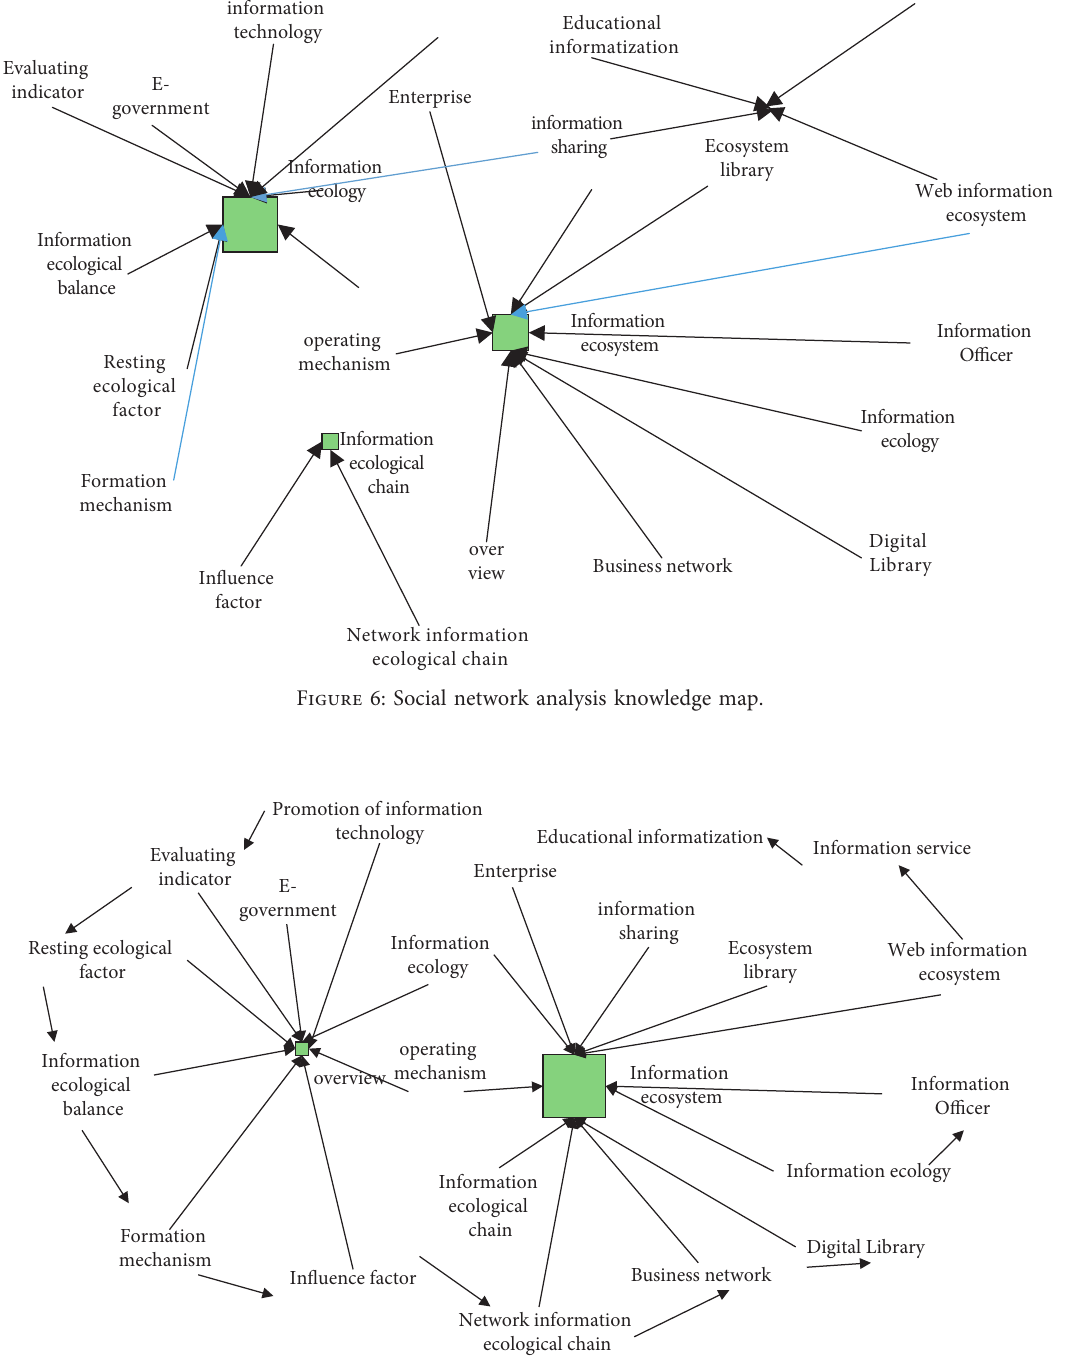
Figure 7: Knowledge mapping of information ecology research from an integrated